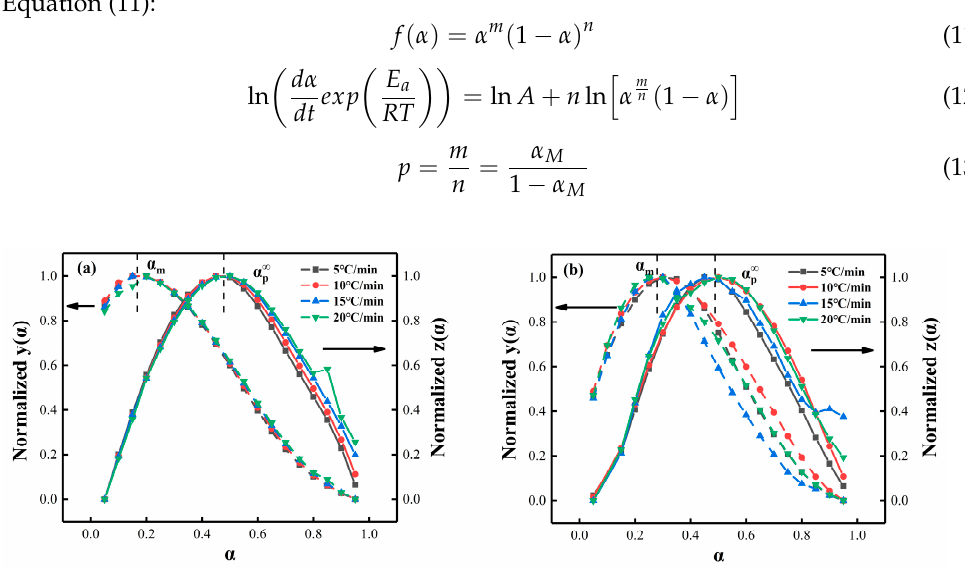
Figure 8. The normalized y ( α ) vs. z ( α ) curves of ( a ) PNE-177/DDS and ( b ) PNE-177/DICY systems.